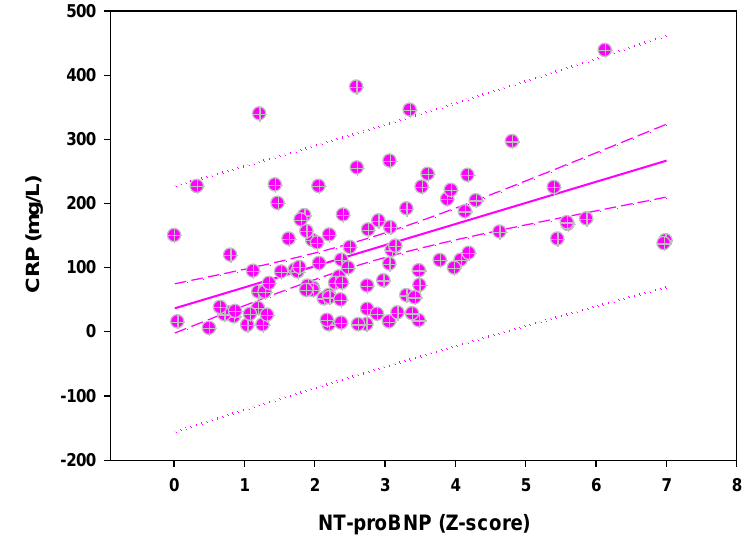
Figure 2. A high serum C-reactive protein (CRP) concentration in association with increased NT-proBNP is a witness of the degree of